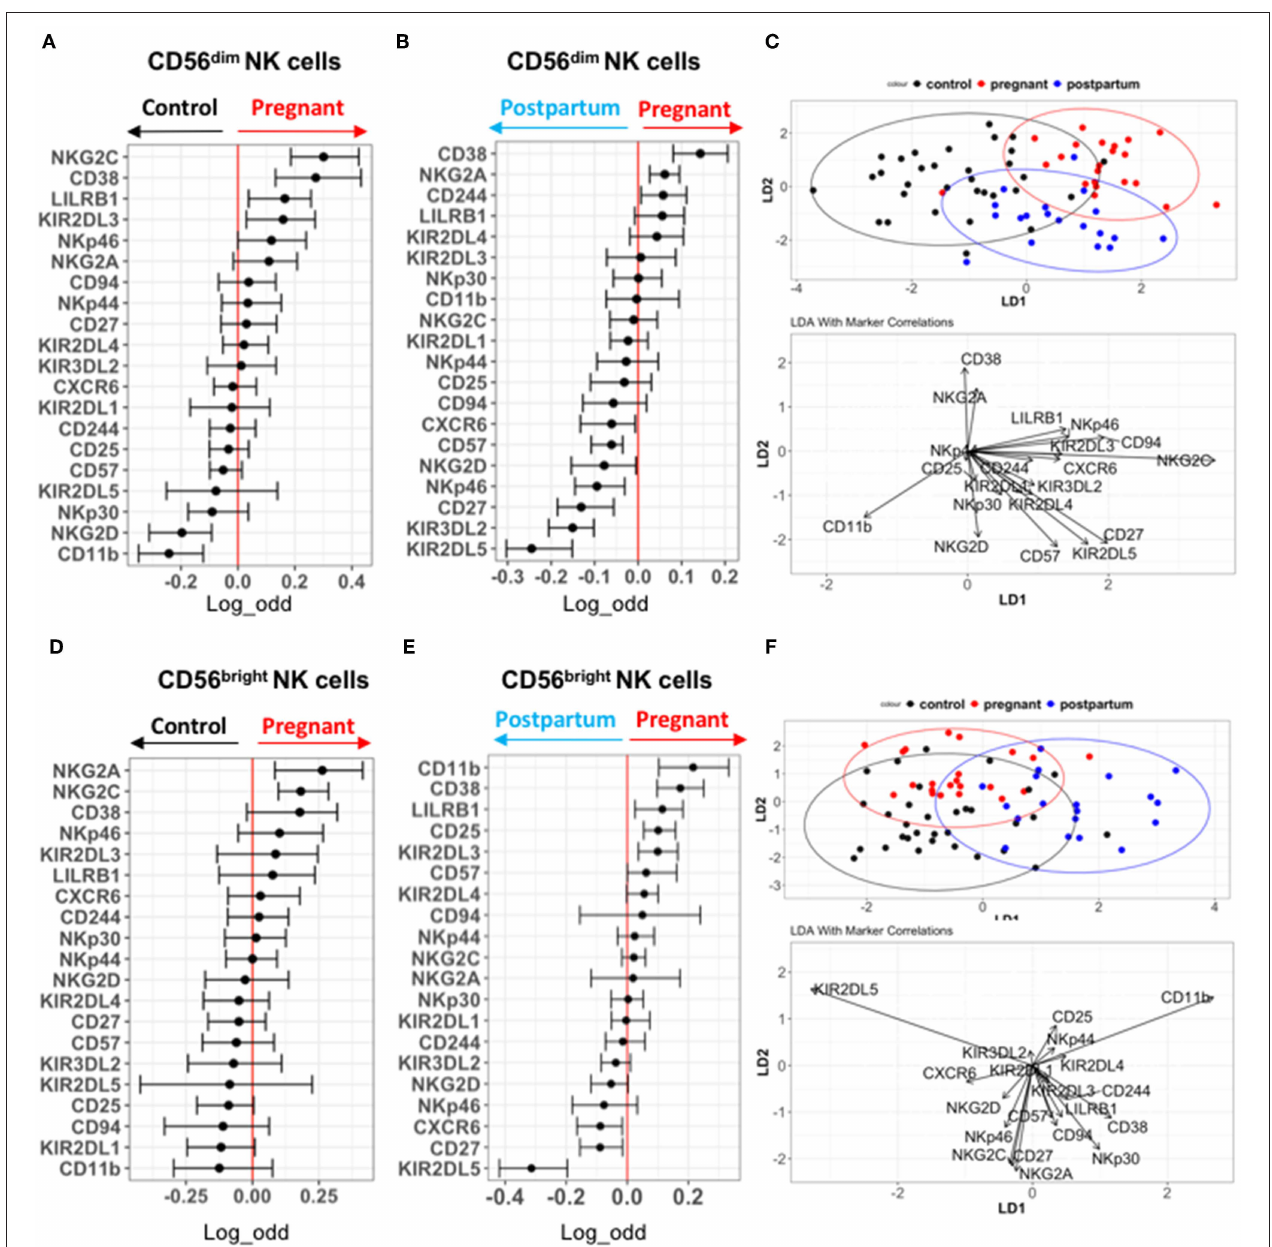
FIGURE 3 | Deep profiling of CD56 dim and CD56 bright NK cells in non-pregnant and pregnant women from validation cohort. (A,B) Markers predictive of CD56 dim NK cells in control vs. pregnant women in validation cohort were assessed by GLM with bootstrap resampling. The markers are listed on the y-axis and the x-axis represents the log-odds that the marker expression levels predict the outcome (control on the left vs. pregnancy on the right). Summary data are depicted, showing the 95% confidence interval. Markers in which the bar does not cross zero are significantly predictive of one state vs. the other. (C) Represents the linear discriminant analysis (LDA) for CD56 dim NK cells between non-pregnant, pregnant and post-partum samples from validation cohort. (D,E) Markers predictive of CD56 bright NK cells in control vs. pregnant women in validation cohort were assessed by GLM with bootstrap resampling. The markers are listed on the y-axis and the x-axis represents the log-odds that the marker expression levels predict the outcome (control on the left vs. pregnancy on the right). Summary data are depicted, showing the 95% confidence interval. Markers in which the bar does not cross zero are significantly predictive of one state vs. the other. (F) Represents the linear discriminant analysis (LDA) for CD56 bright NK cells between non-pregnant, pregnant and post-partum samples from validation cohort.